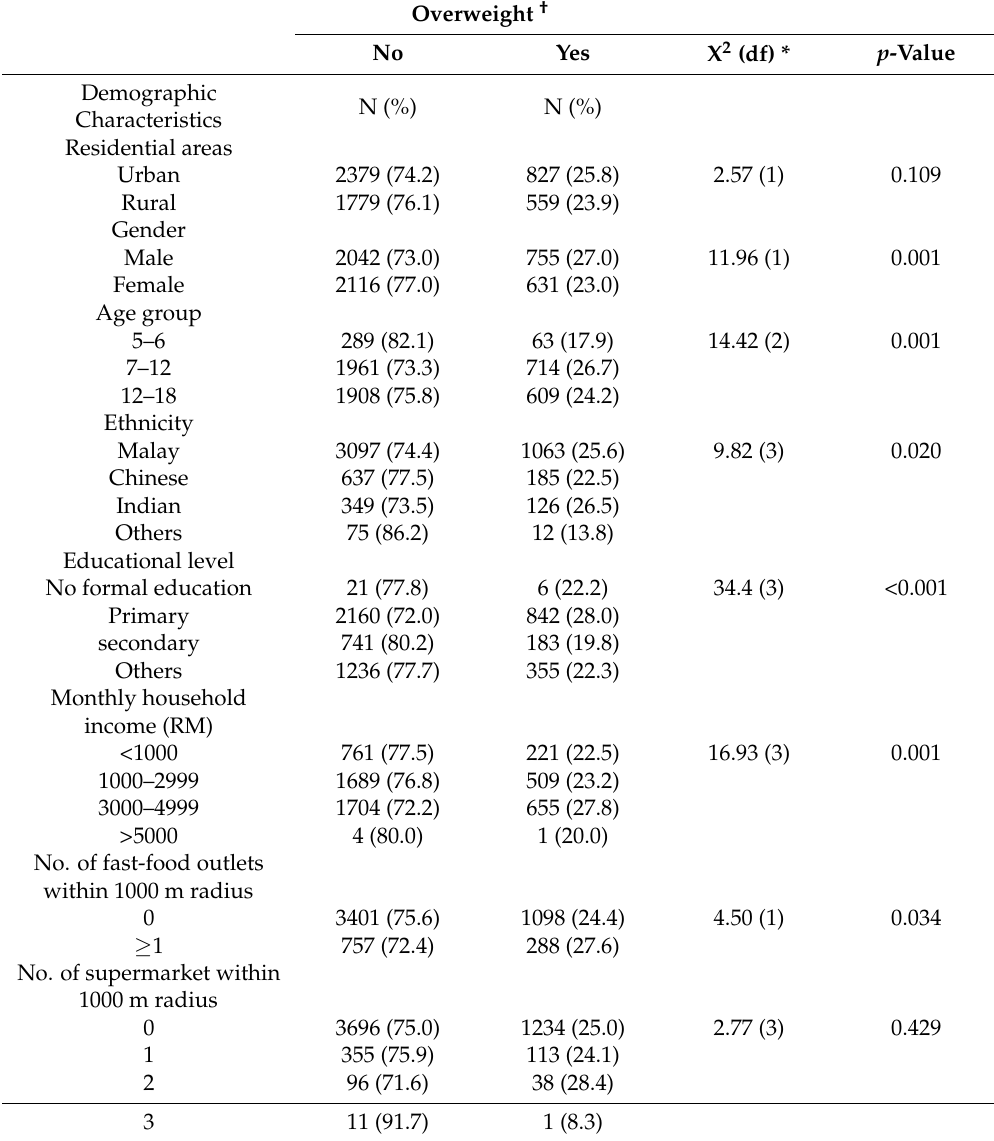
Table 1. Sociodemographic characteristics of children ( n = 5544). Overweight † No Yes X 2 (df) * p